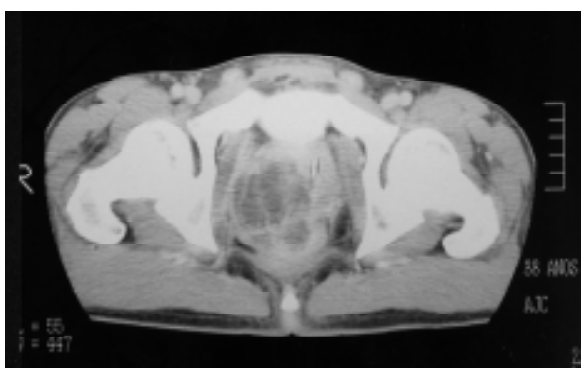
Figure 2 – Pelvic computed tomography showing an abscess in the prostate.